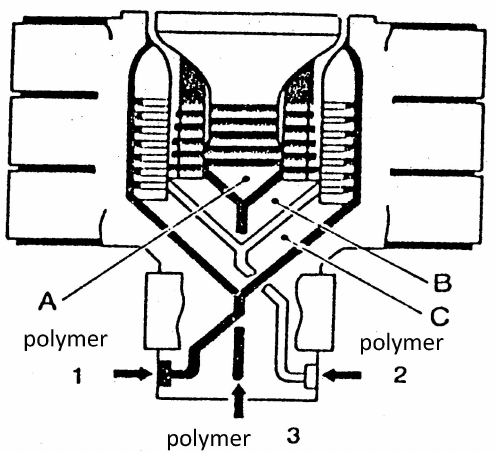
Figure 1. Example of a multilayer film blowing die geometry (Reprinted from Ref.